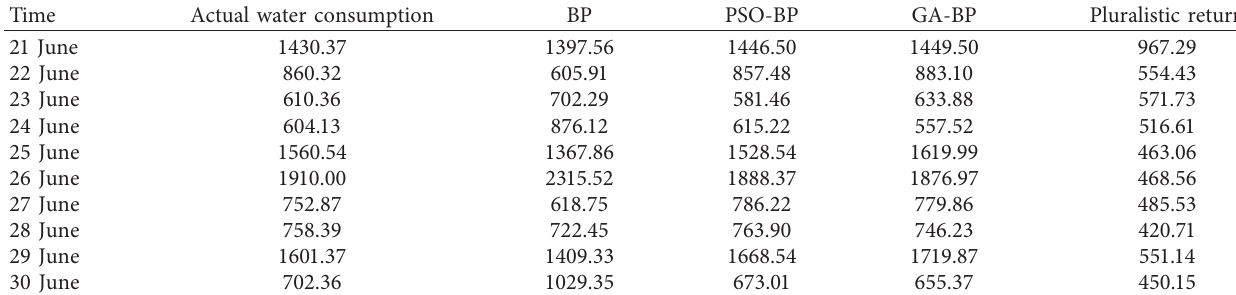
Table 5: Prediction results of different